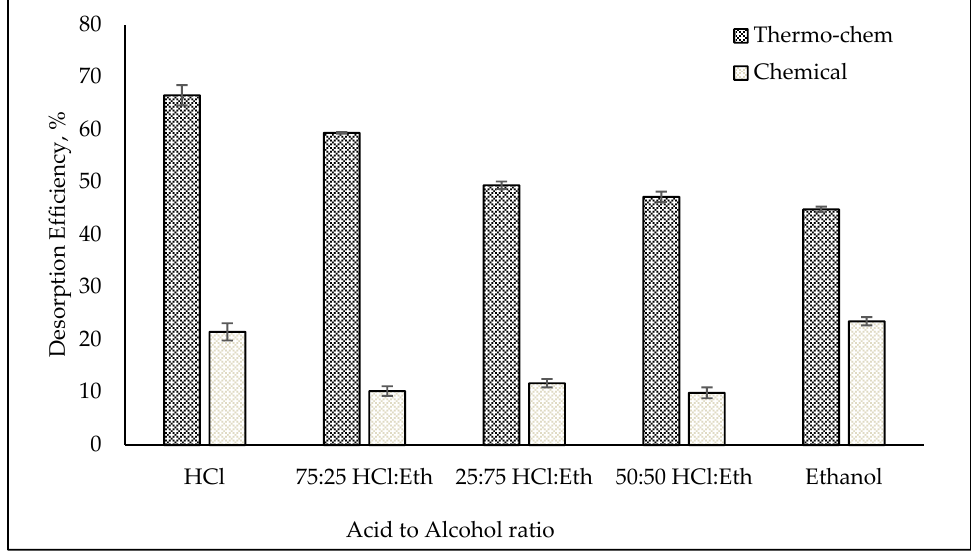
Figure2. E ff Figure 2. Effect of solvents on the desorption of methylene blue dye (MB) from the clay adsorbent coating.